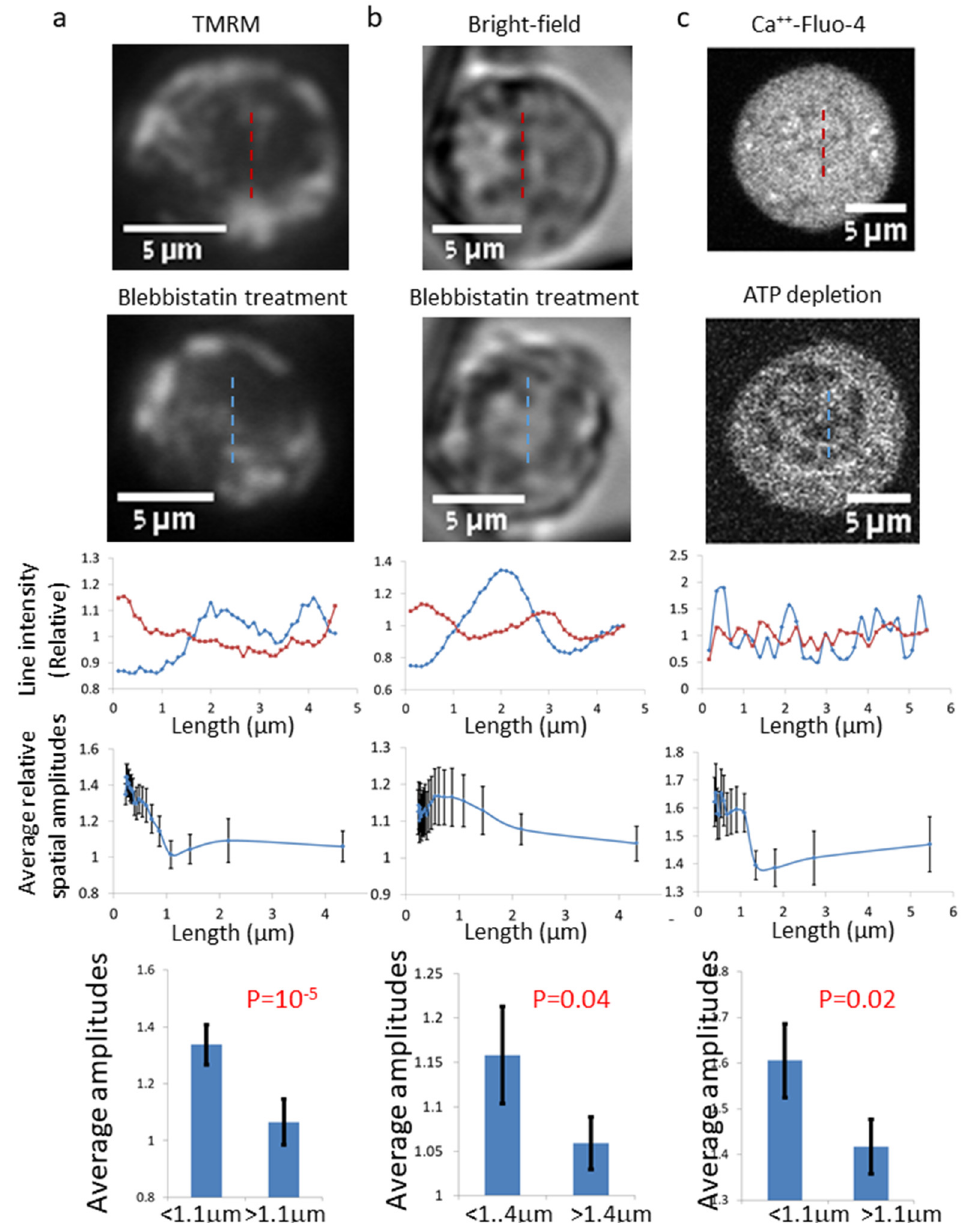
Figure 2. Inhomogeneity in living cells imaged by TMRM fluorescence (N = 21) ( a ), or label-free bright-field (BF) microscopy (N = 62) ( b ) and its relation to 10 µ M blebbistatin treatment. Inhomo- geneity in living cells imaged by Ca ++ -Fluo-4 fluorescence (N = 31) and its relation to ATP depletion treatment ( c ). From top to bottom rows: a representative cell before treatment, the same cell after treatment (blebbistatin or ATP depletion), its line scans of relative intensities (the pixels intensity divided by the average ROI intensity) before and after treatment, the average (for all cells) relative spatial amplitudes (see Figure 1) and the comparison of the average relative spatial amplitudes in two ranges of length. Error bars are SEM and p -values are